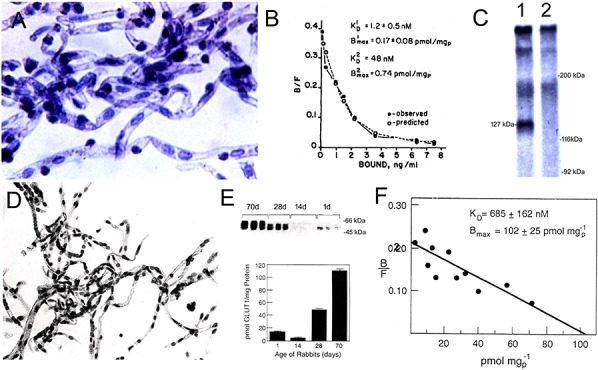
(A) Microvessels isolated from human autopsy brain are used as a source of the membrane bound human insulin receptor. Magnification is 200X. (B) Binding of [125I]-insulin to human brain microvessels is saturable, and a Scatchard plot of the binding data shows the dissociation constant (KD) of insulin binding to the HIR is high affinity with a KD of 1.2 ± 0.5 nM. (C) Affinity cross-linking of [125I]-insulin to human brain microvessel-derived plasma membranes shows a single specific band of molecular weight of 127 kDa (lane 1), whereas this binding site is eliminated in the presence of 10 ug/mL unlabeled insulin (lane 2). Panels (A–C) are reprinted by permission from Pardridge et al. (1985a). (D) Microvessels isolated from adult rabbit brain are used for the characterization of the BBB glucose transporter. (E, top panel) Quantitative Western blot of microvessels isolated from rabbits 1, 14, 28, or 70 days of age, using a rabbit polyclonal antiserum against a carboxyl terminal 13 amino acid peptide of the human GLUT1 glucose transporter that is phylogenetically conserved. The 54 kDa Glut1 rabbit glucose transporter is detected, and varies with the postnatal age of the rabbit (E, bottom panel). Amount of Glut1 glucose transporter in microvessels isolated from rabbits of different ages is measured with the Quantitative western blot using purified human erythrocyte glucose transporter as the assay standard. (F) Scatchard plot of D-glucose displaceable binding of [3H]-cytochalasin B to brain microvessels isolated from the 70 day old rabbit shows the total number of all Glut binding sites in the rabbit brain microvessel is not significantly different from the total number of Glut1 sites as determined by quantitative Western blotting. Panels (E,F) are reprinted by permission from Dwyer and Pardridge (1993).